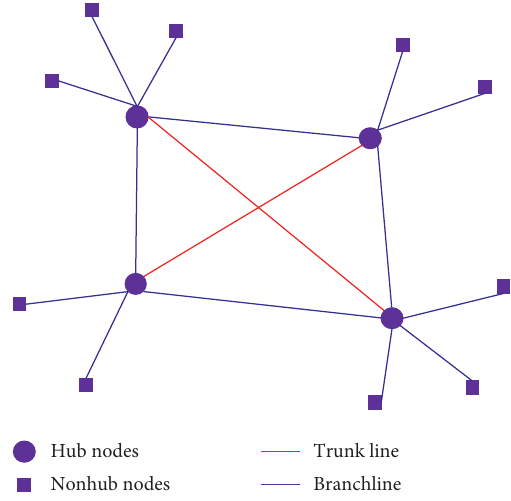
Figure 1: Hub-and-spoke network. The purple circles represent hub nodes and purple squares represent nonhub nodes. The thick red line indicates the trunk line, and the thin blue line indicates the branch